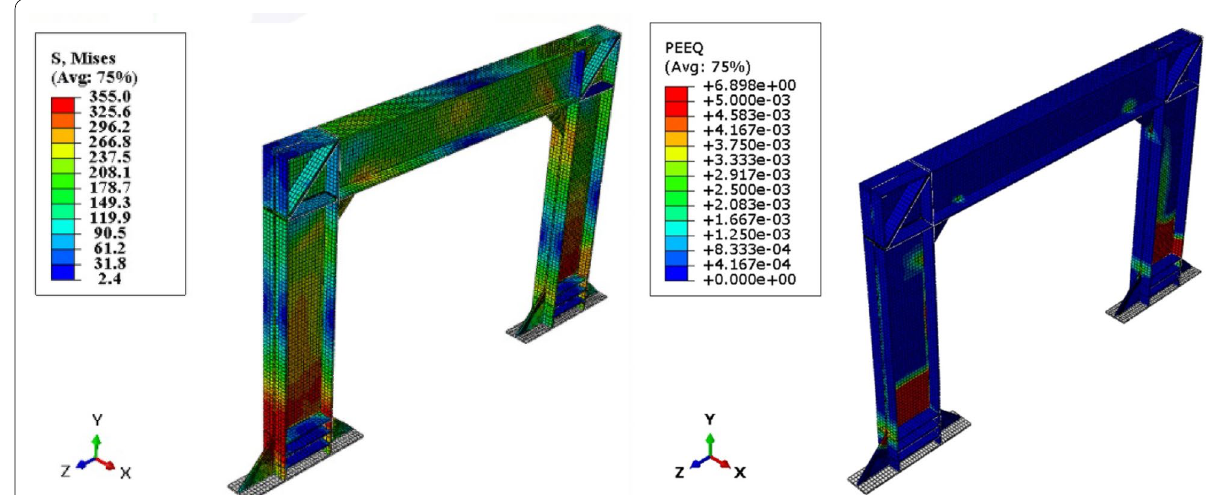
Fig. 24 Final distribution of Mises stress and equivalent plastic strain in ABAQUS